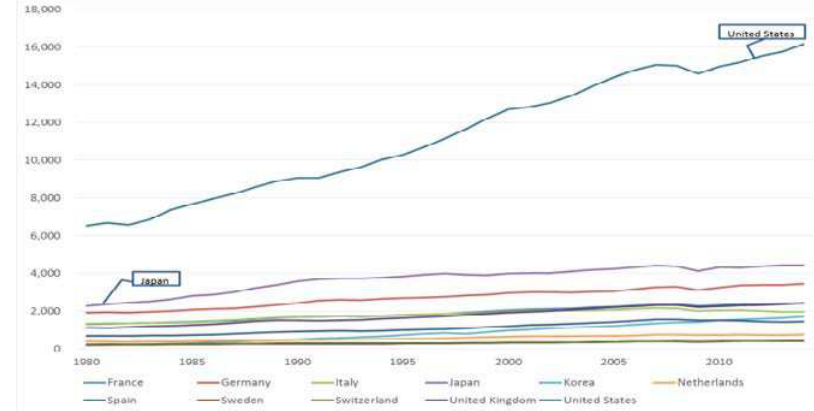
Fig. 3. Real GDP (trillion US$ in